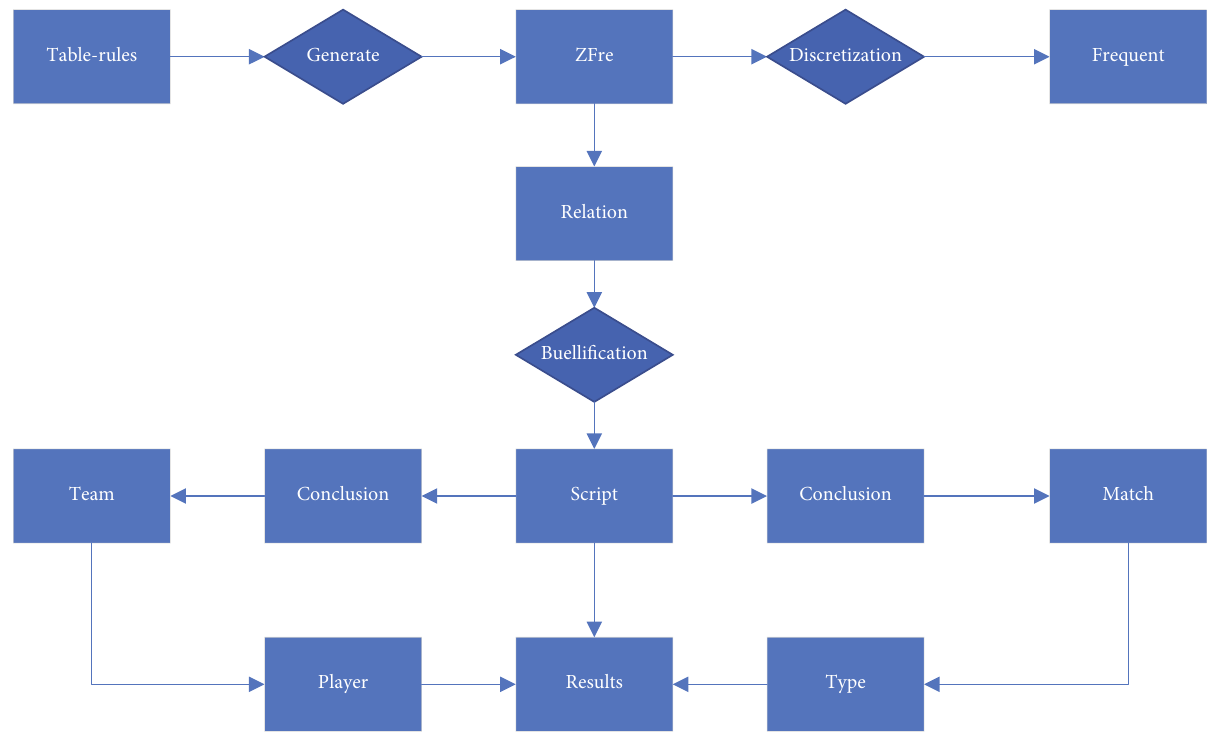
Figure 3: Database system